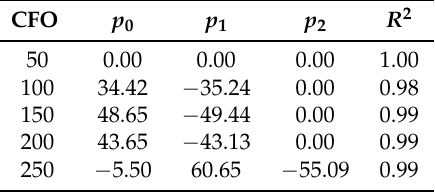
Table 3. Fitting coefficients and R 2 index.